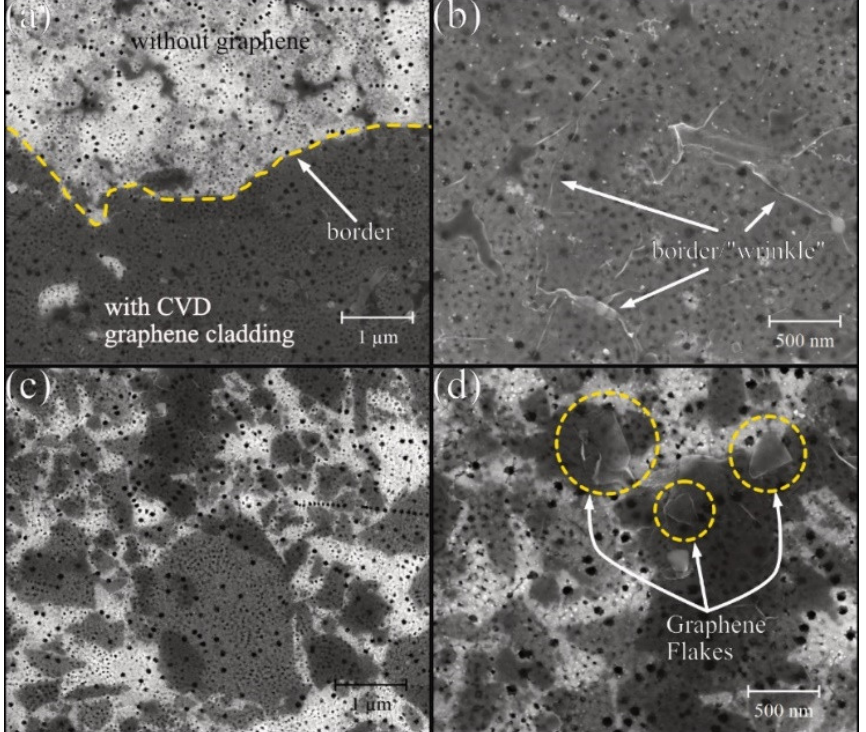
Figure 3. Electron micrographs of various graphene claddings ( a ) CVD−grown, showing contrast difference between area with and without graphene cladding; ( b ) CVD−grown, exhibiting continuous film; ( c ) micron−sized EC−exfoliated graphene flakes; ( d ) magnified view of EC−exfoliated graphene flakes.